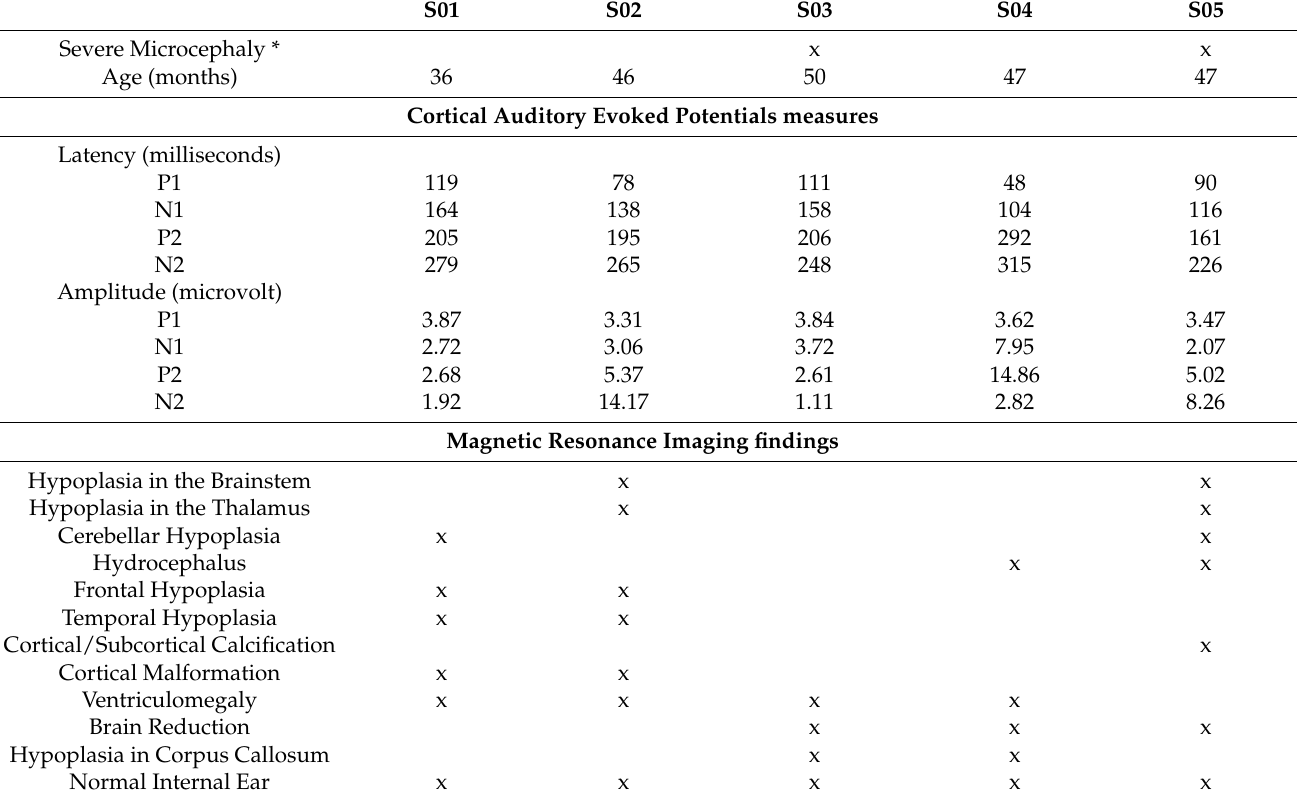
Table 1. Description of age and severity of microcephaly as a measurement and frequency of changes in imaging of five children with microcephaly ( n = 5). S01 S02